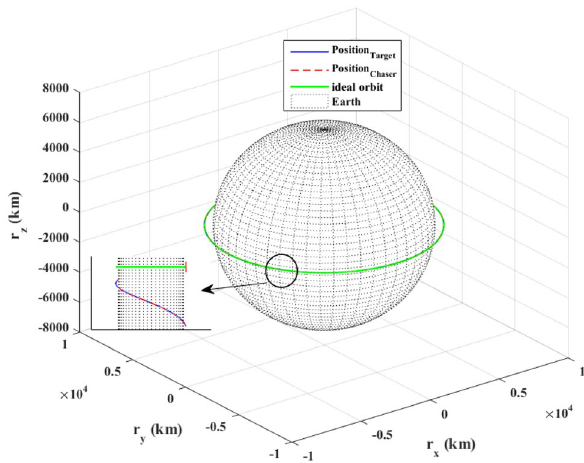
Figure 68. Scenario III: target’s and chaser’s motion path VS target’s ideal orbit (5000 s).